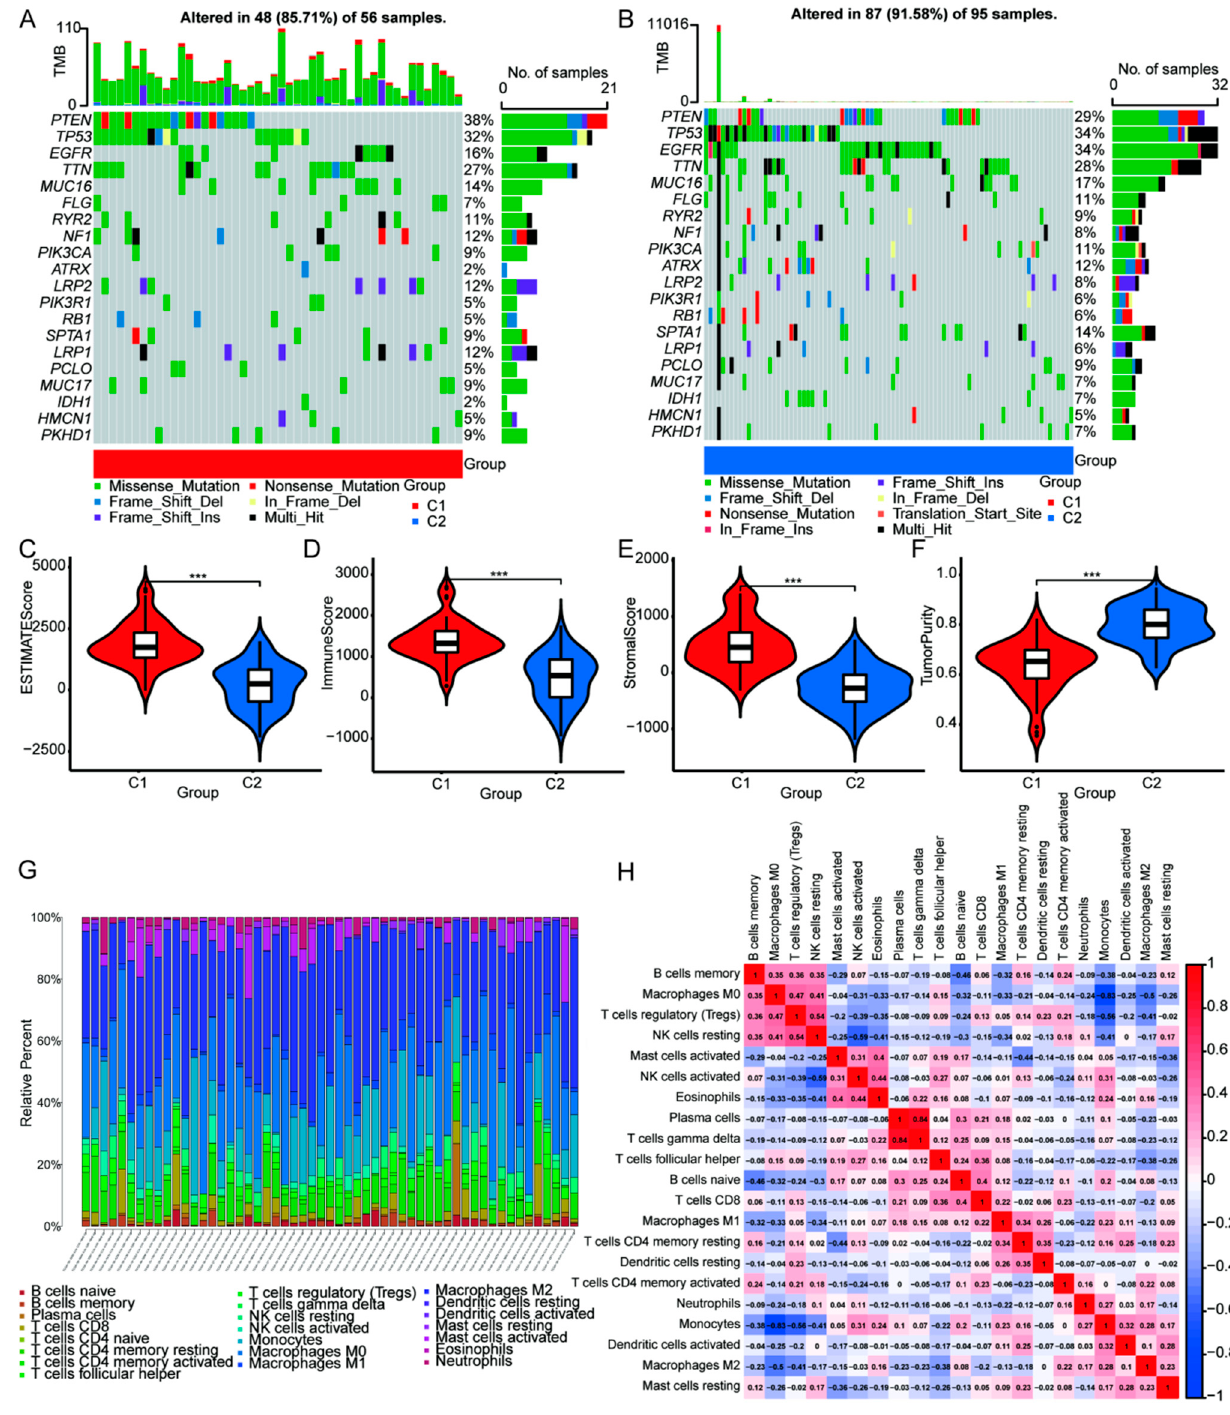
Figure 4. Comparison of somatic mutations, immune landscape and correlation in ICD genotyping of high-grade glioma. The top 20 most frequently mutated genes were oncoprint visualized in C1 ( A ) and C2 group ( B ). ESTMATES score ( C ), ImmuneScore ( D ), StromalScore ( E ), TumorPurity ( F ) in different ICD genotyping. ( G ) The immune cell composition of each glioma sample. ( H ) Correlation analysis of different immune cells in glioma samples. (*** p < 0.001 vs. indicated group)